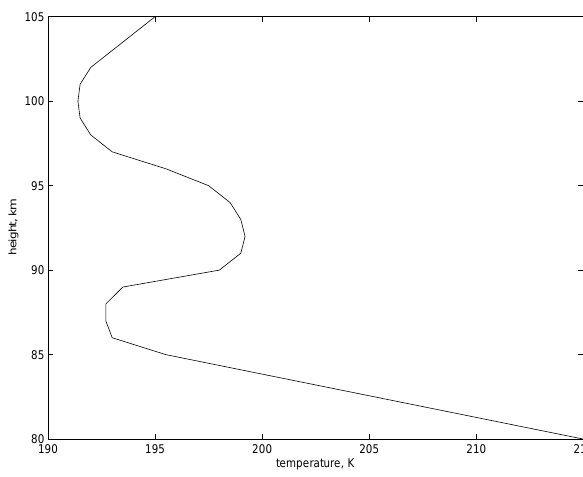
Fig. 7. Temperature height profile calculated with the heating rate shown in Fig. 4 and the other processes discussed in Sect. 2.